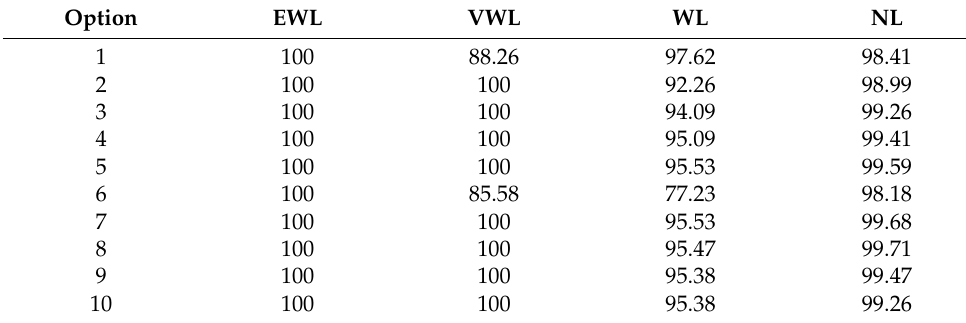
Table 6. Baseline A ambiguity-fixed rate for different linear combinations (%).